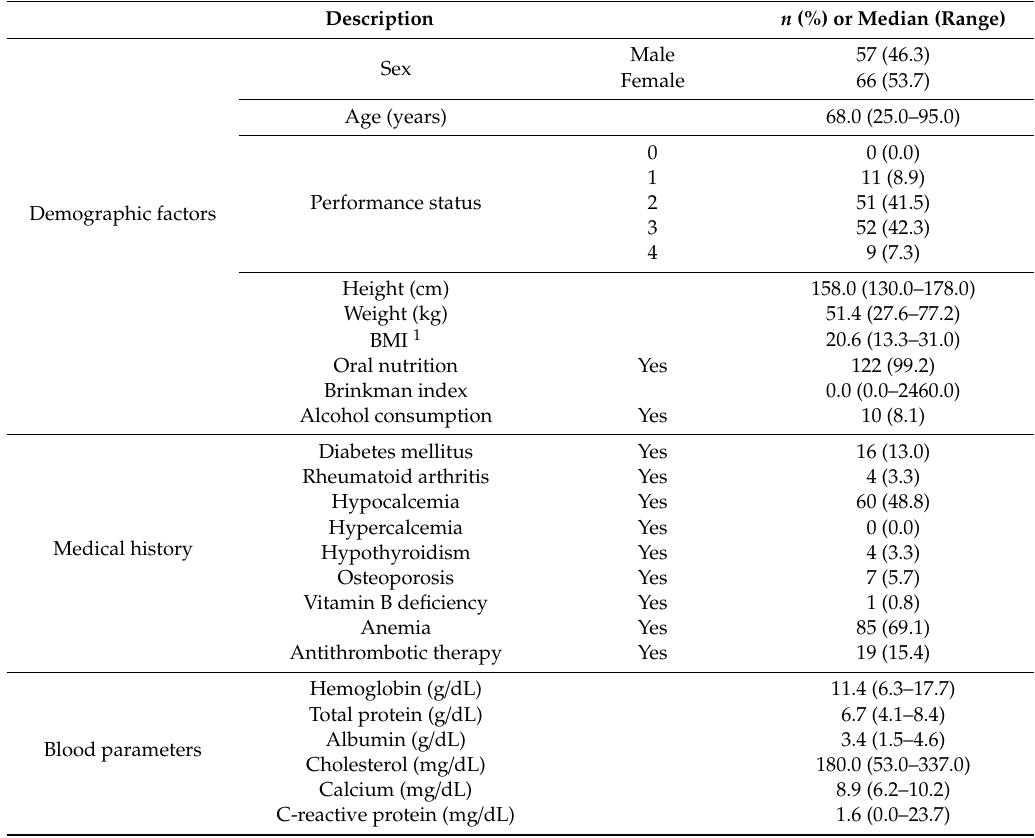
Table 1. Patient